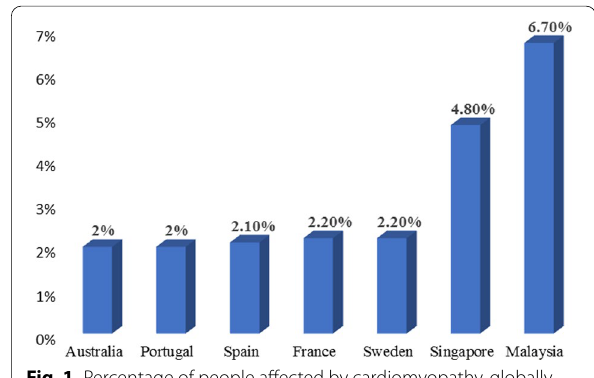
Fig. 1 Percentage of people affected by